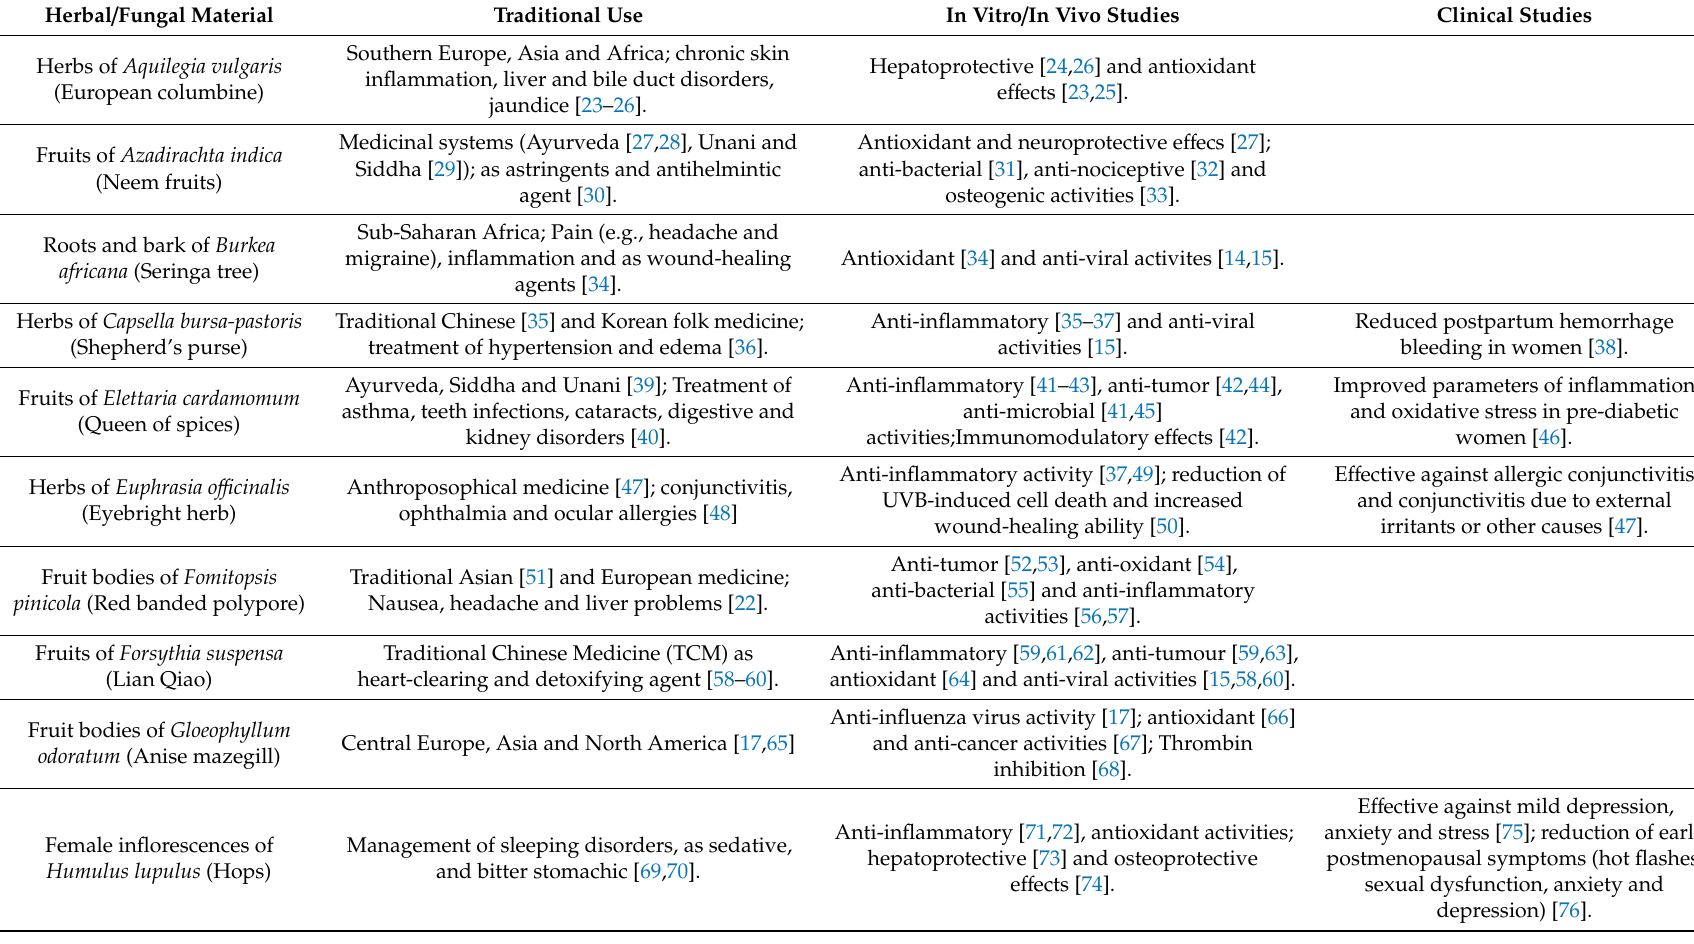
Table 2. Herbal and fungal materials with anti-inflammatory activity selected for this study, including their traditional application and reported in vitro and in vivo data; clinical evidence also includes studies not directly linked to